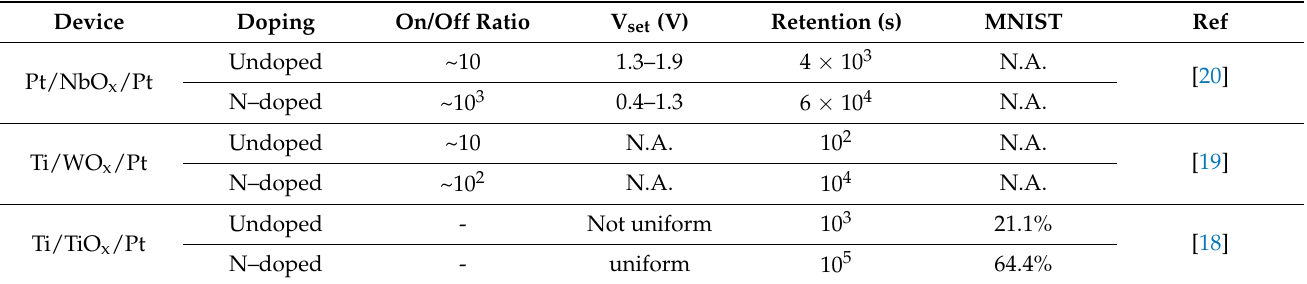
Table 1. Performance of N–doped Memory Devices Compared with Undoped Memory Device in Previous